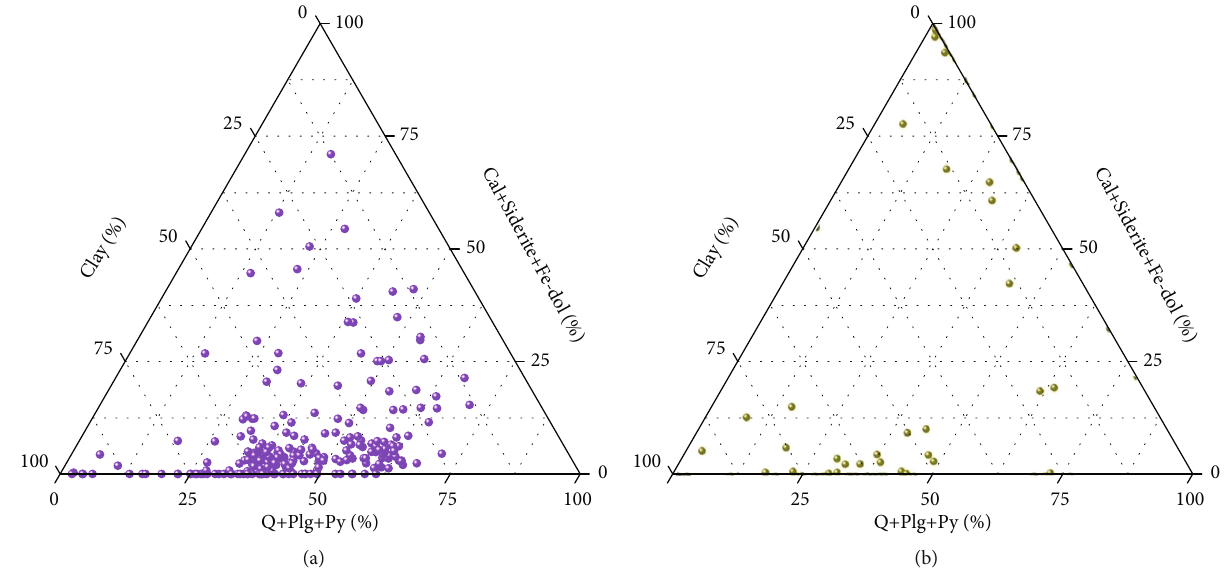
Figure 4: (a) Ternary diagram showing the distribution of di ff erent minerals in the Shanxi Formation. (b) Ternary diagram showing the distribution of di ff erent minerals in the Taiyuan Formation. Note: Q =quartz; Plg=plagioclase; Py =pyrite; Cal=calcite; Fe-dol =Fe-